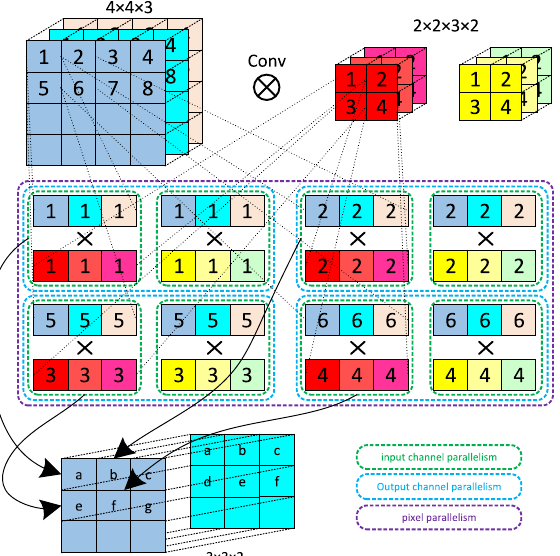
Figure 3. The parallel acceleration of the convolution layer is divided into three main dimensions: input channel parallelism, output channel parallelism, and pixel